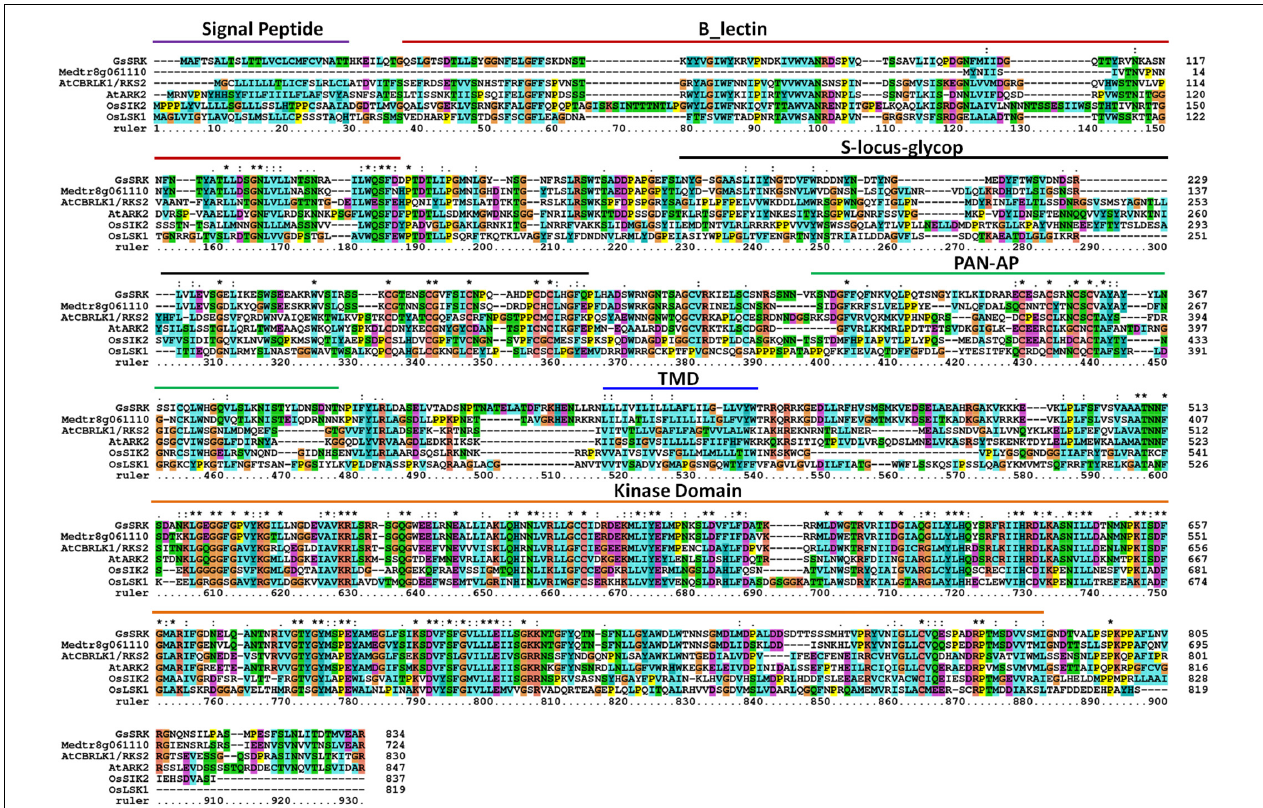
FIGURE 1 | Multiple alignment of GsSRK and its homologous proteins. The full length amino acid sequences of GsSRK and its homologous proteins were used for multiple alignment by using Clustal software. The position of the conserved domains was marked according to GsSRK protein sequence. The accession numbers for GsSRK homologous proteins were Medtr8g061110, LOC_Os07g08860 (OsSIK2), LOC_Os01g47900 (OsLSK1), At1g11350 (AtCBRLK1/RKS2), and At1g65800